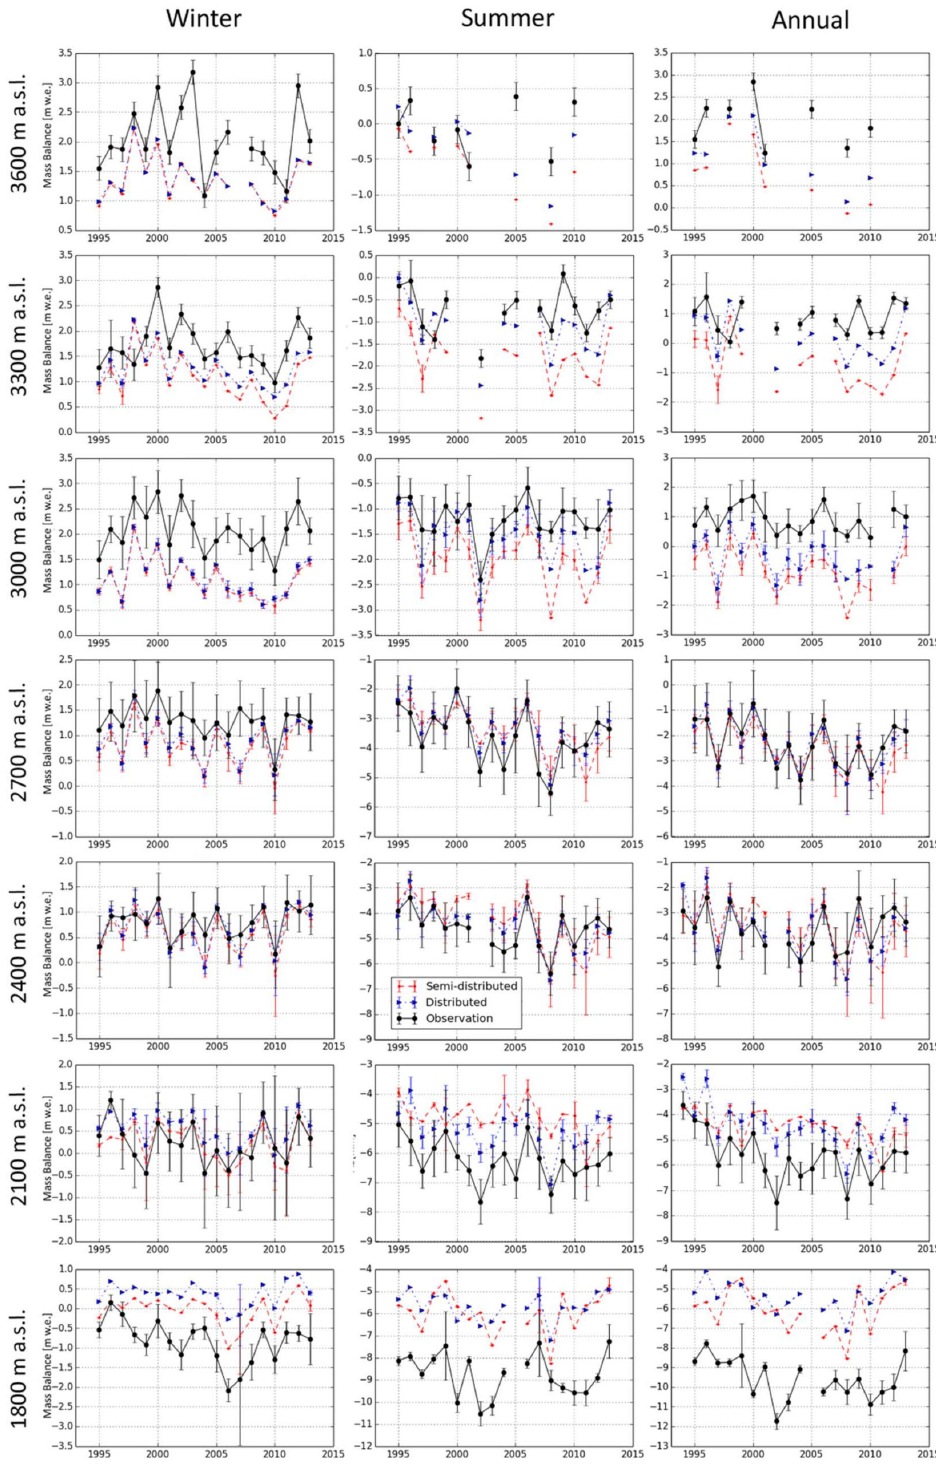
Figure 11. Temporal evolution of the observed and simulated (semi-distributed and distributed) SMB for the Mer de Glace glacier for the seven 300-m elevations bands for the period 1994–2013. The points show the average observation and simulation values for the same measurement locations, and the vertical bars show the standard deviations for those